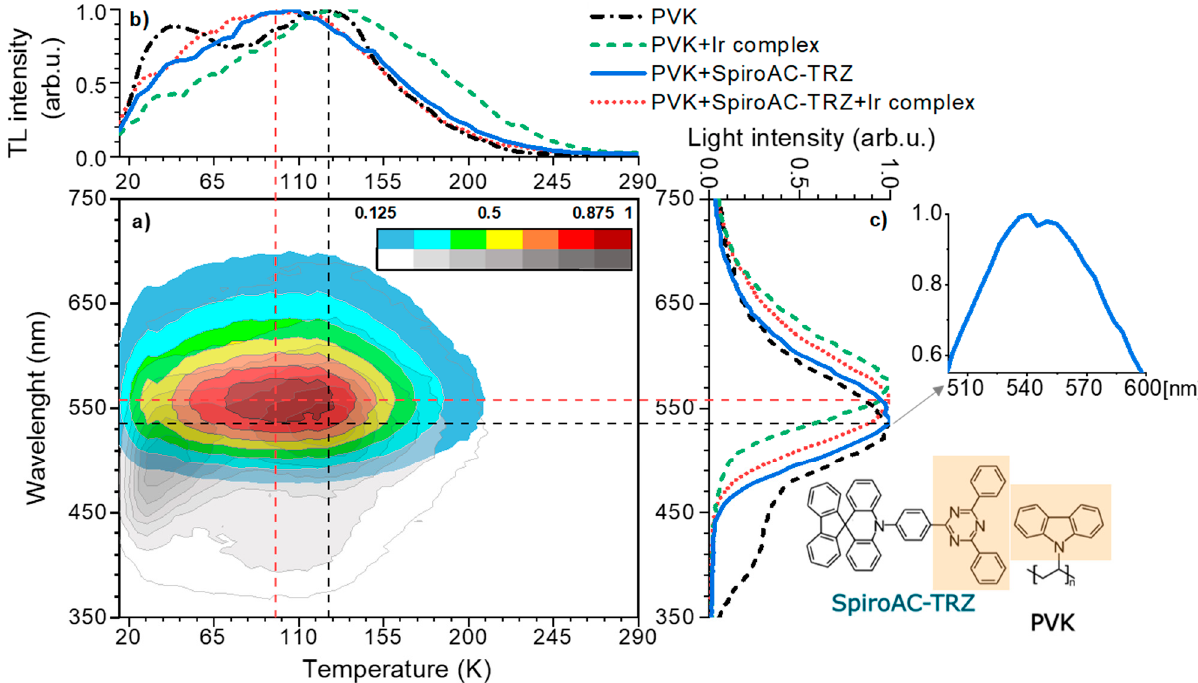
Figure 8. Spectrally resolved thermoluminescence (SRTL) spectra of layers of neat PVK, doped with 2 wt% of Ir, doped with 25 wt% of SpiroAC–TRZ and doped with 25 wt% SpiroAC–TRZ + 2 wt% Ir. ( a ) Thermoluminescence (TL) maps of layers of neat PVK and of PVK + 25 wt% SpiroAC–TRZ + 2 wt% Ir. ( b ) Normalized monochromatic TL curves recorded at emission maxima ( λ ~550 nm). ( c ) Isothermal spectra of emitted light recorded at temperature corresponding to TL maxima. Inset shows emission curve of PVK+25 wt% SpiroAC–TRZ layer, in range of 500–600 nm. Straight lines on SRTL map indicate: selected wavelength for monochromatic TL curves (horizontal lines) and selected temperature for isothermal spectra of emitted light (vertical lines).